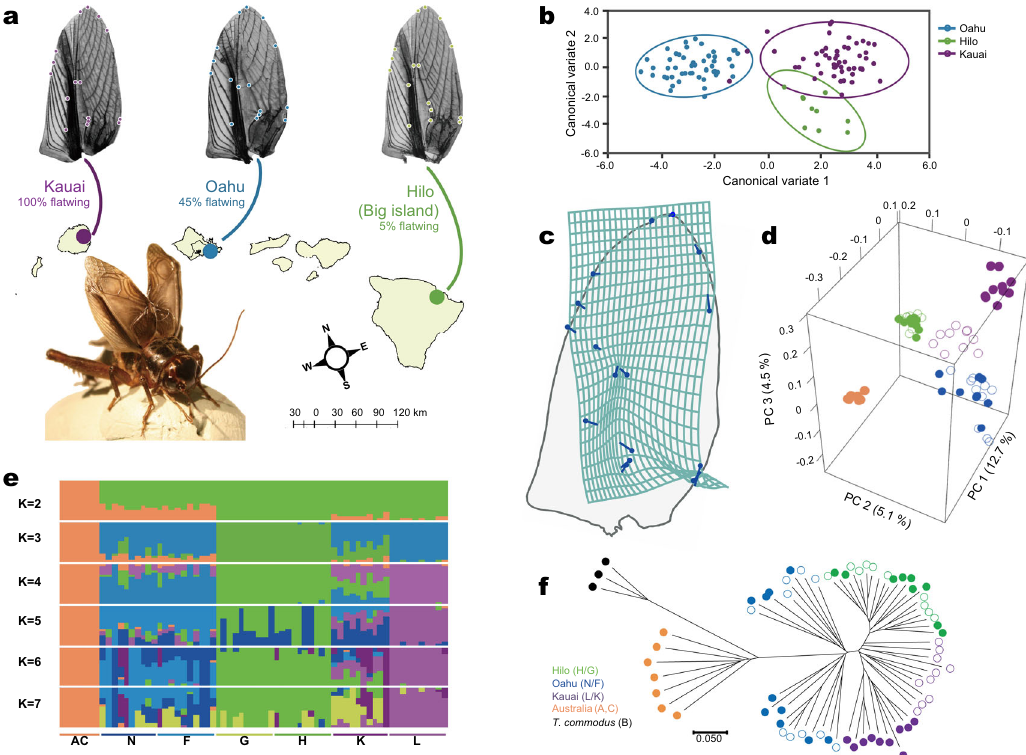
Fig. 1 Geographic, morphological and genetic variation in silent Hawaiian crickets. a Representative right forewings of fl atwing T. oceanicus males from populations on the Hawaiian islands of Kauai, Oahu and the Big Island (Hilo). Map drawn using QGIS v2.18.24 (http://qgis.org). Dots on wing veins indicate geometric morphometric landmarks, and colours re fl ect the scheme used in this manuscript if not stated otherwise (purple = Kauai, blue = Oahu, green = Hilo). Bottom left photo: A normal-wing male for comparison (Photo credit: N.W. Bailey). b Flatwing wing venation differs among the three populations. Canonical variates analysis (CVA) showing multivariate differences in wing veins of fl atwing males from Kauai, Oahu and Hilo. Source data are provided as a Source Data fi le. c Deformation grid illustrating the major differences in forewing venation between fl atwing males from the three populations. The outline indicates a generic male forewing, and arrows show vectors representing landmark variation on CV1 (scaling factor of 10). d There is clear population genetic differentiation among the three islands. Genome-wide differentiation among T. oceanicus populations shown in a three- dimensional PCA scatter diagram based on autosomal SNPs. Australian T. oceanicus outgroup samples are indicated in orange. Solid circles = normal-wing males, open circles = fl atwing males. e However, population structure analysis indicated an optimal group size of K = 5, likely re fl ecting our inclusion of lab-raised normal-wing Kauai males and lab-raised fl atwing Hilo males. Different colours indicate genetically distinct groups. f Neighbour-joining phylogenetic tree based on autosomal SNPs. Symbols and colour coding for T. oceanicus samples are as above, and black circles = T. commodus outgroup. The scale bar represents the level of genetic